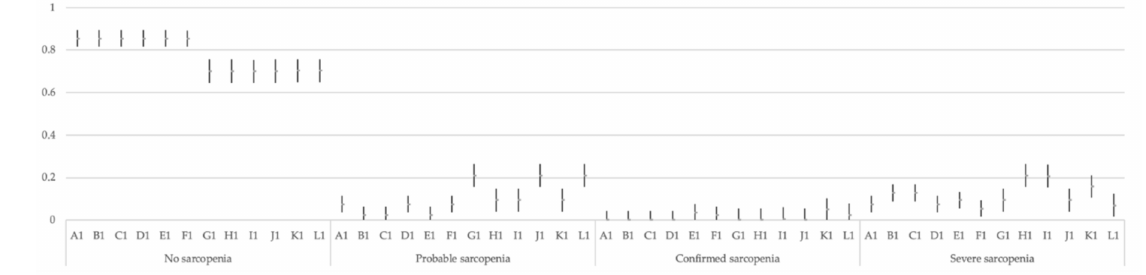
Figure 1. Multinomial 95% confidence intervals for the proportion of each category in the 12 options of Model